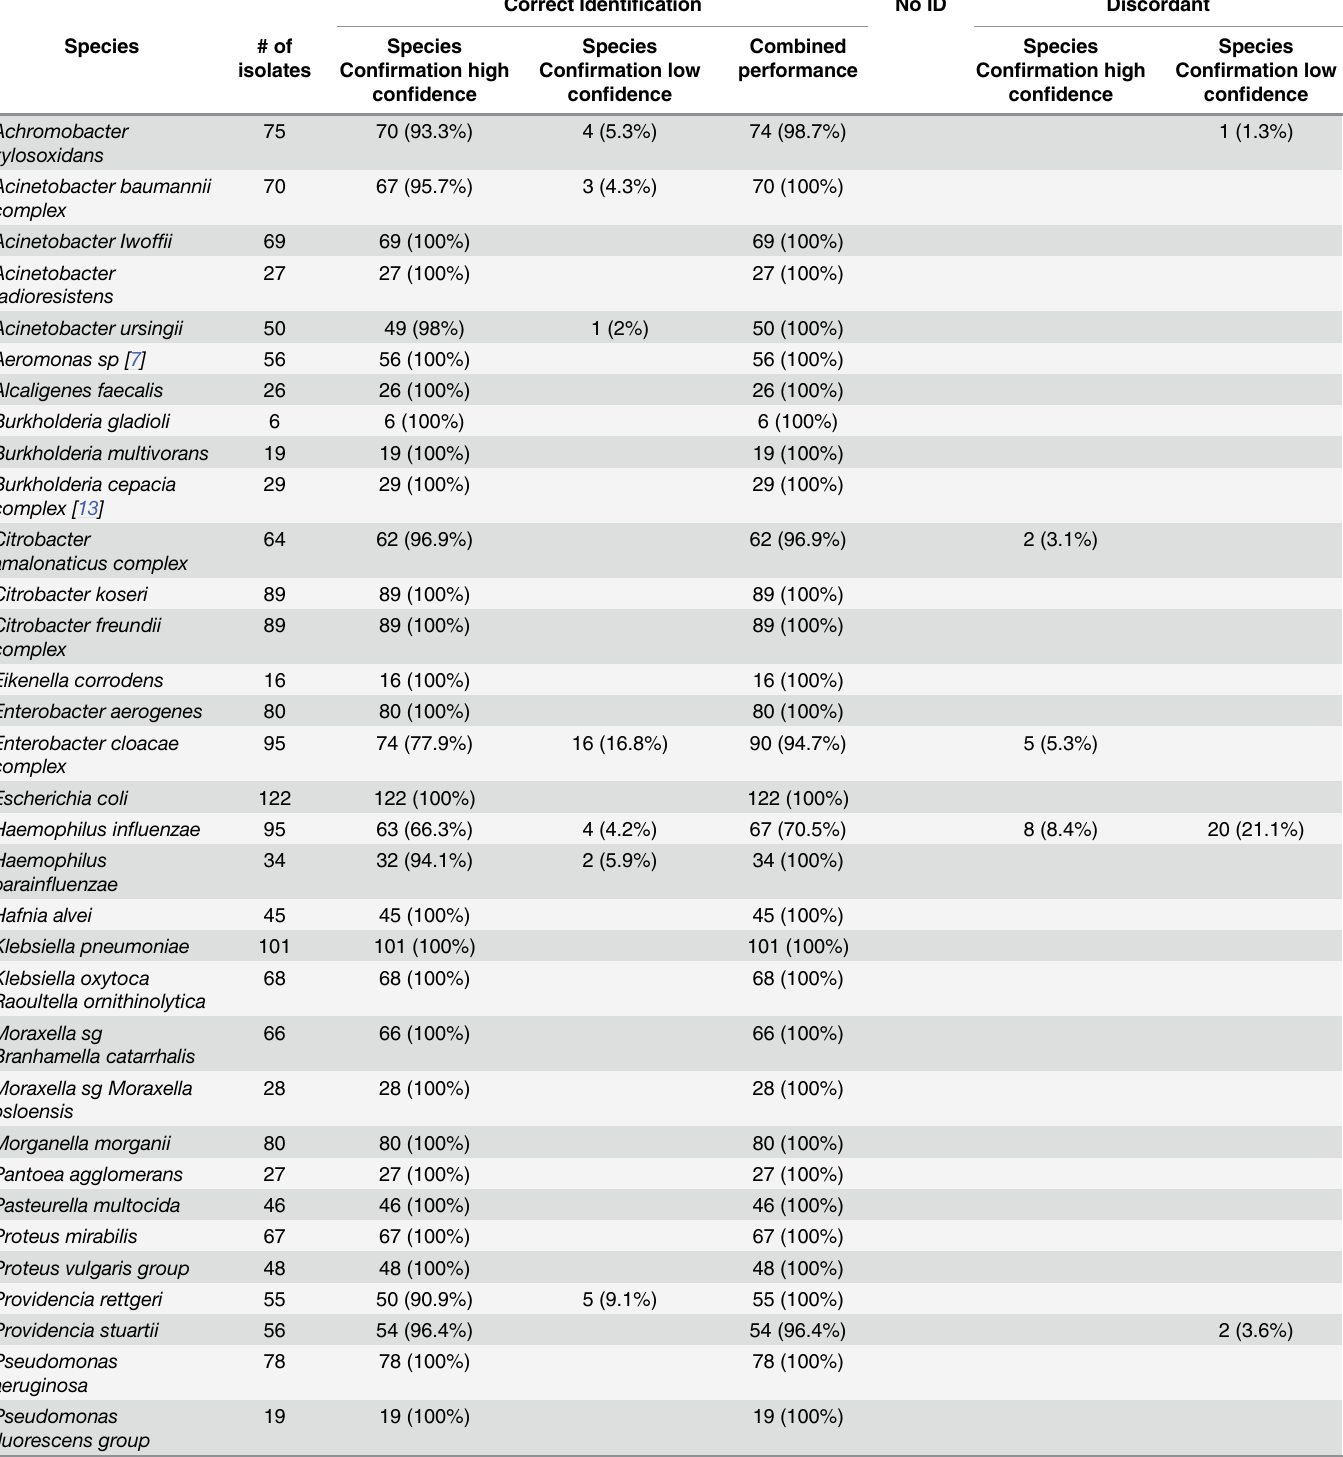
Table 3. Performance of MBT-CA System for identification of aerobic Gram negative